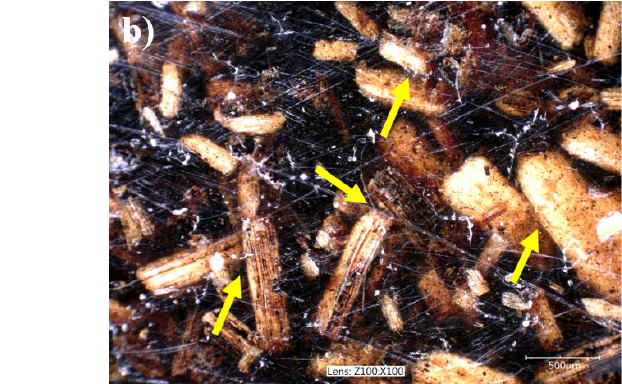
Figure 3. Physical contact between the sunflower husk particles in HDPE composites. Arrows show some physical contact points. The white scratches are the imprints of the steel mold. Filler content: 40 vol%. ( a ) SP20; ( b ) SPF. Table 4. The dispersion and polar surface tension components of the polymers used in the study, and the reversible work of adhesion in their composites. Matrix